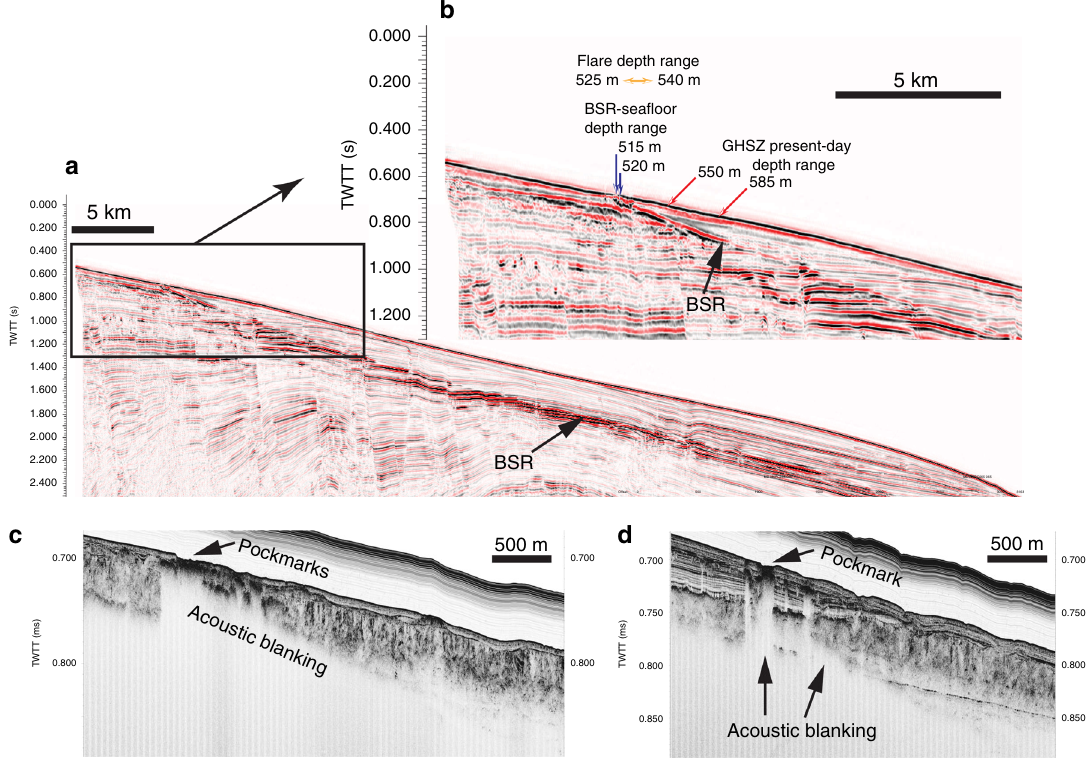
Fig. 2 Regional seismic line and sub-bottom pro fi les. a Multichannel seismic pro fi le showing the bottom simulating re fl ector (BSR) cross-cutting stratal re fl ections and rising upslope to intercept the sea fl oor; b detail of ( a ) showing the BSR outcropping at sea fl oor in water depths of 515 – 520 m; orange arrows indicate the depth range of most of the fl ares in the area (525 – 540 m), red arrows indicate the present-day depth range of the gas hydrate stability zone (GHSZ) calculated from bottom water temperatures (550 – 585 m); c , d Autonomous underwater vehicle (AUV)-mounted sub-bottom pro fi les showing acoustic blanking below the pockmark fi eld and the BSR, consistent with free gas rising from BSR depth towards sea fl oor. The pockmark fi eld is located at 520 – 560 m of water depth. See Fig. 1 for locations of the pro fi les.